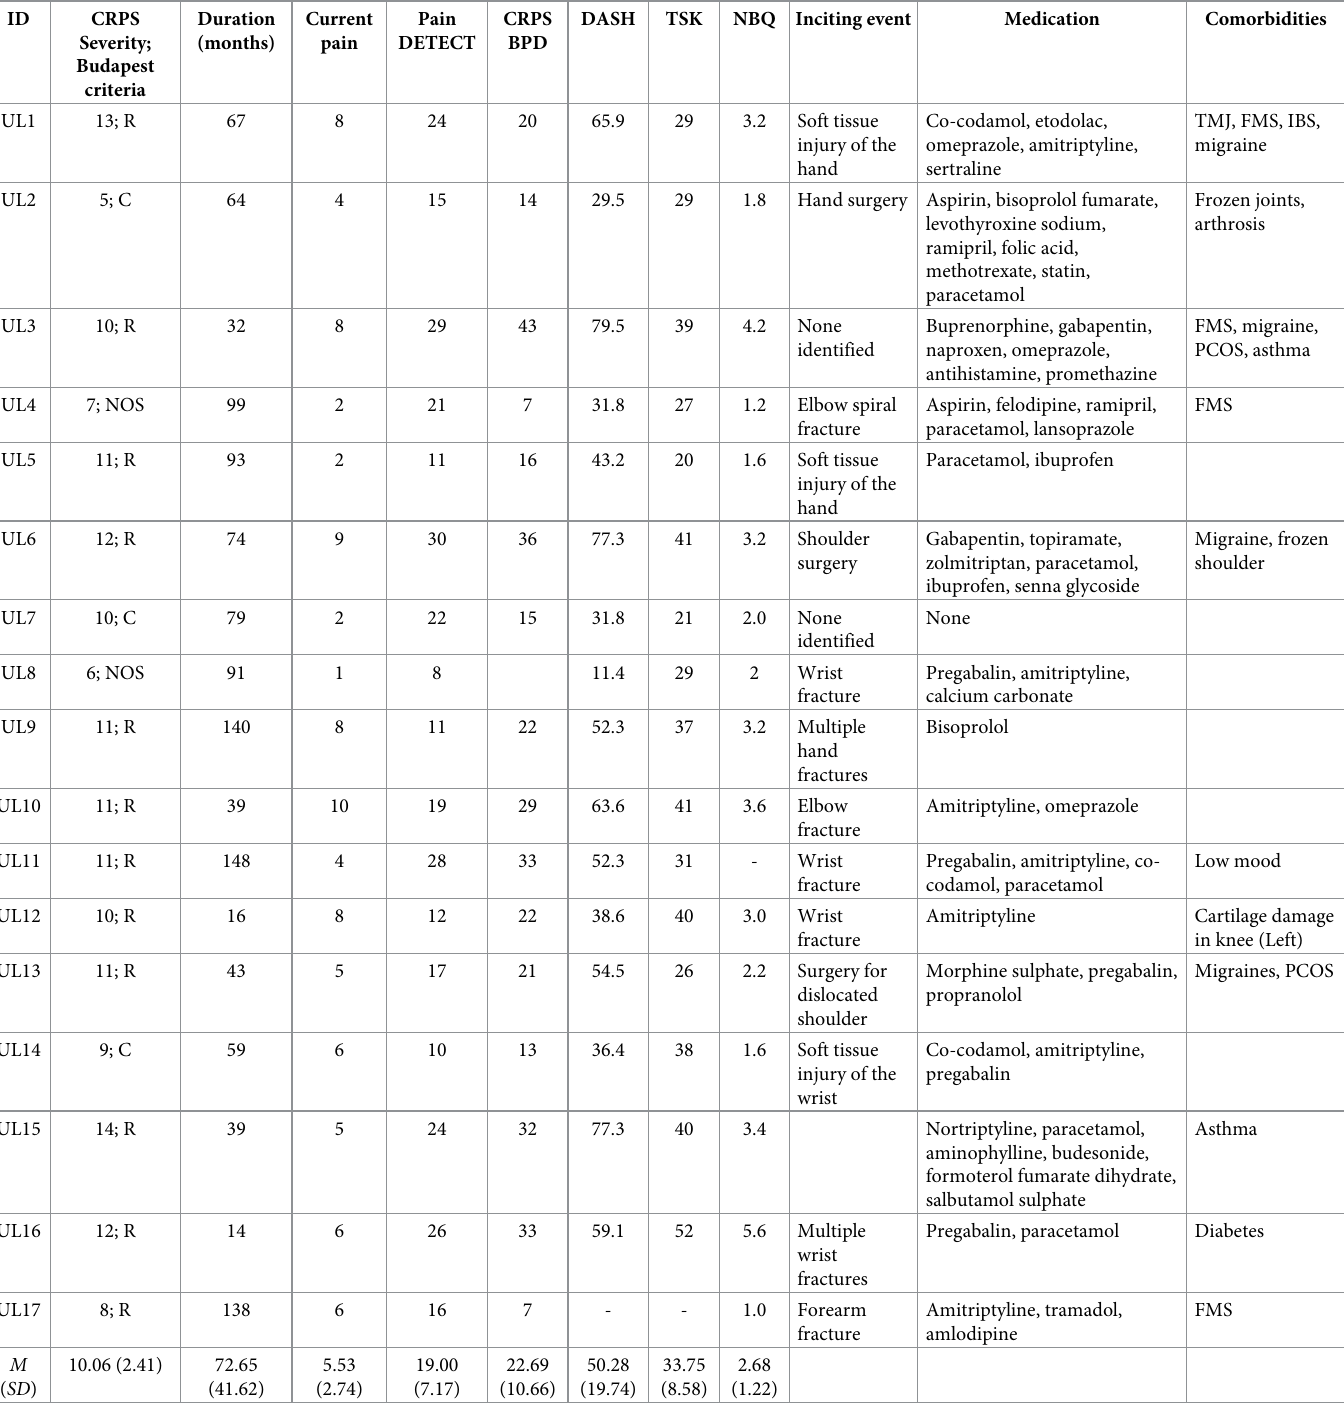
Table 1. Clinical information for people with upper limb